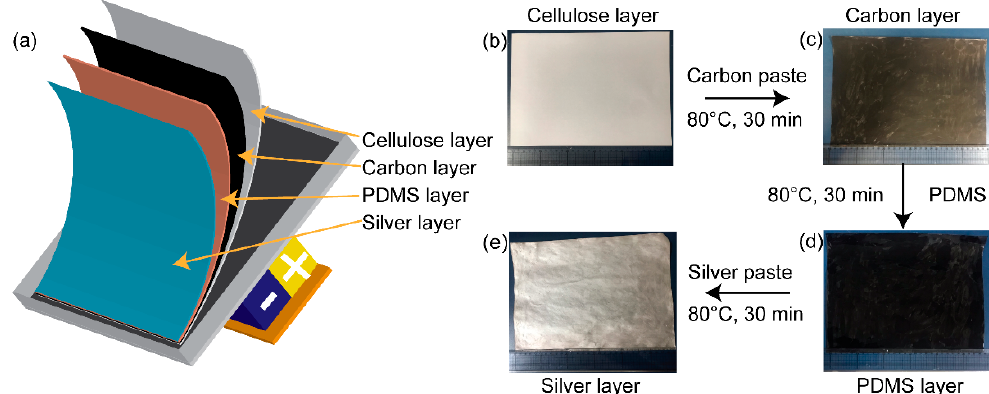
Figure 3. ( a ) Structure of the radiator, ( b ) pristine cellulose fiber sheet, ( c ) carbon layer, ( d ) PDMS layer, and ( e ) silver layer.